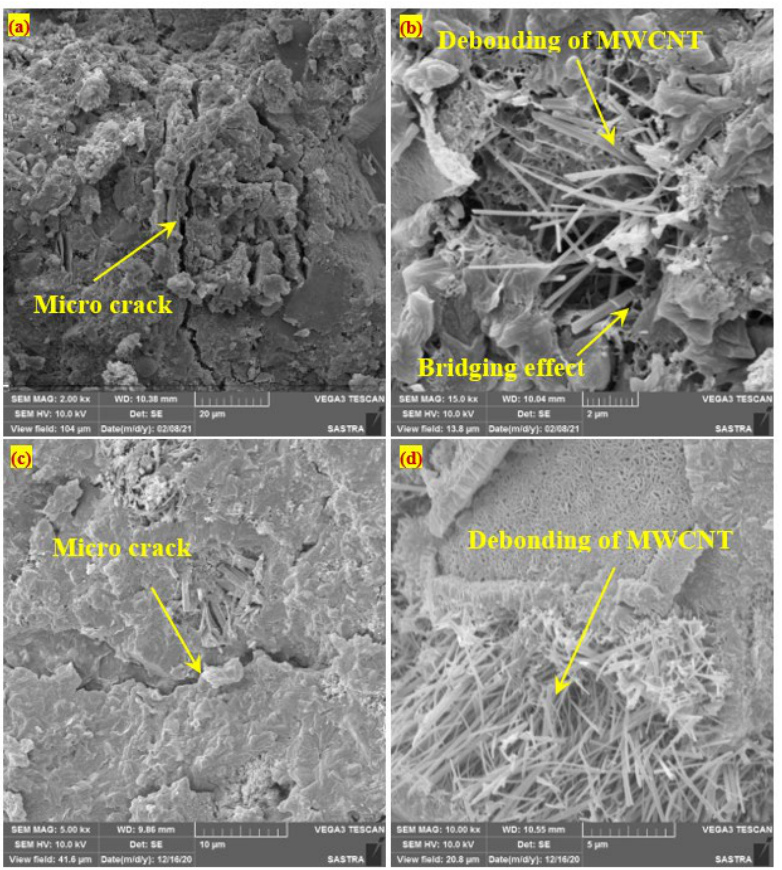
Figure 10. SEM images specimens. ( a ) Micro crack in specimens comprising 0.1% MWCNT; ( b ) Debonding of specimen comprising 0.1% MWCNT; ( c ) Micro crack in specimens comprising 0.2% MWCNT; ( d ) Debonding of specimen comprising 0.2%